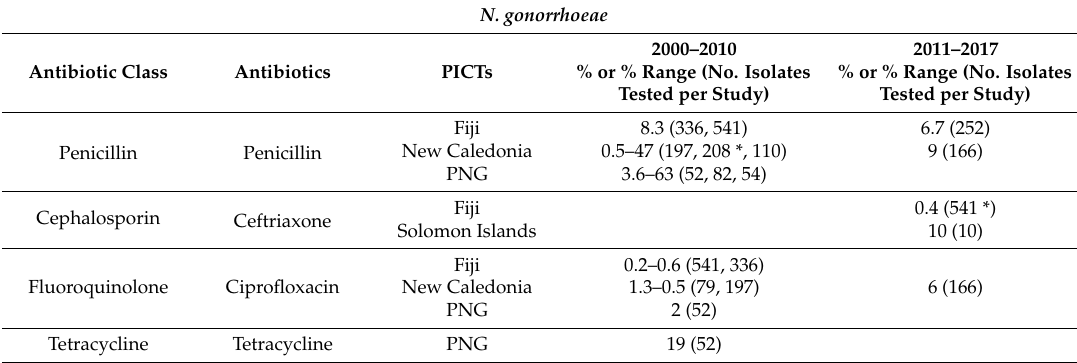
Table 2. Prevalence of ABR in Neisseria gonorrhoeae in PICTs reported by country and date. N.